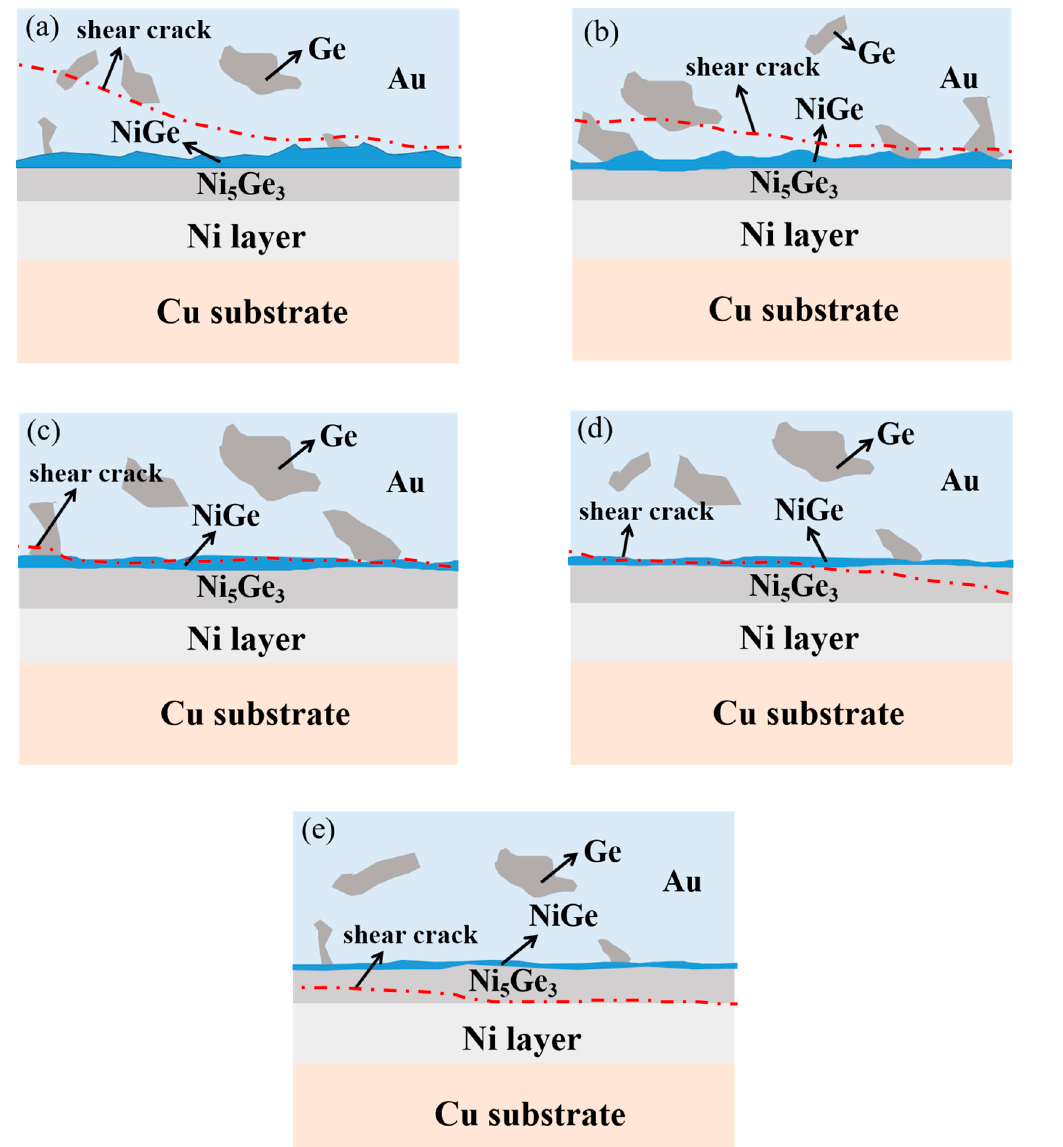
Figure 11. The schematic illustration of shear failures in Au-12Ge/Au/Ni/Cu joints after shock: ( a ) 0 cycle; ( b ) 100 cycles; ( c ) 200 cycles; ( d ) 300 cycles; ( e ) 400 cycles. ( b ) 100 cycles; ( c ) 200 cycles; ( d ) 300 cycles; ( e ) 400